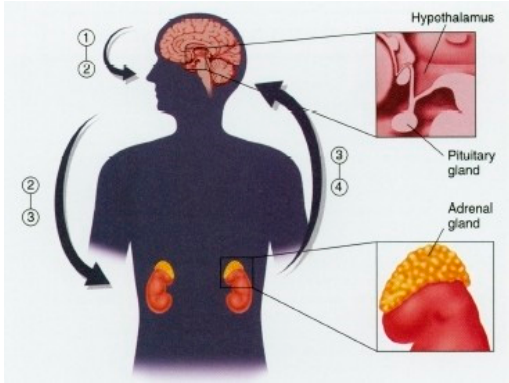
Figure 1. Neuroscience applied to stress control.